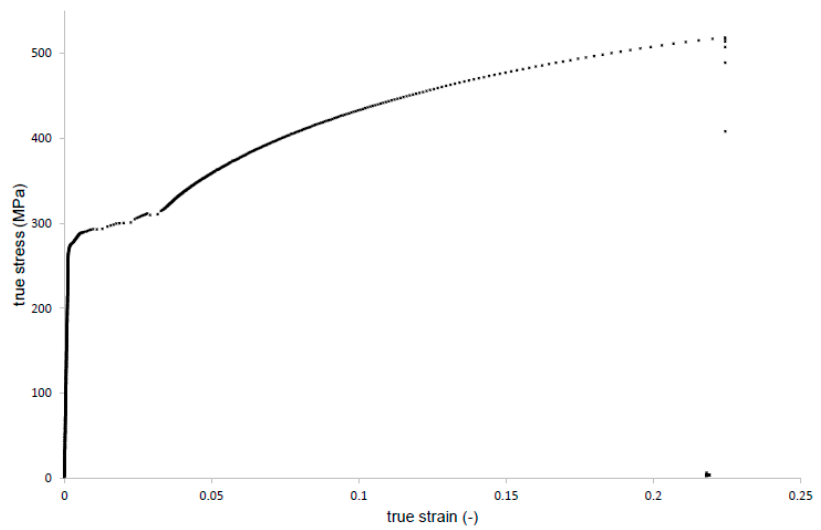
Figure 2. Representative room temperature tensile true stress-true strain curve obtained from the uniaxial tensile test for the old mild steel.